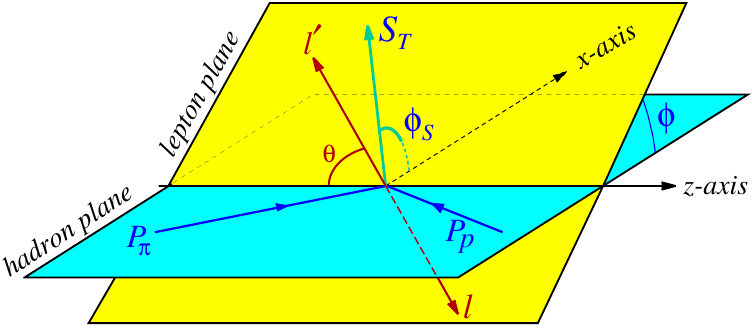
q T , and the produced 2